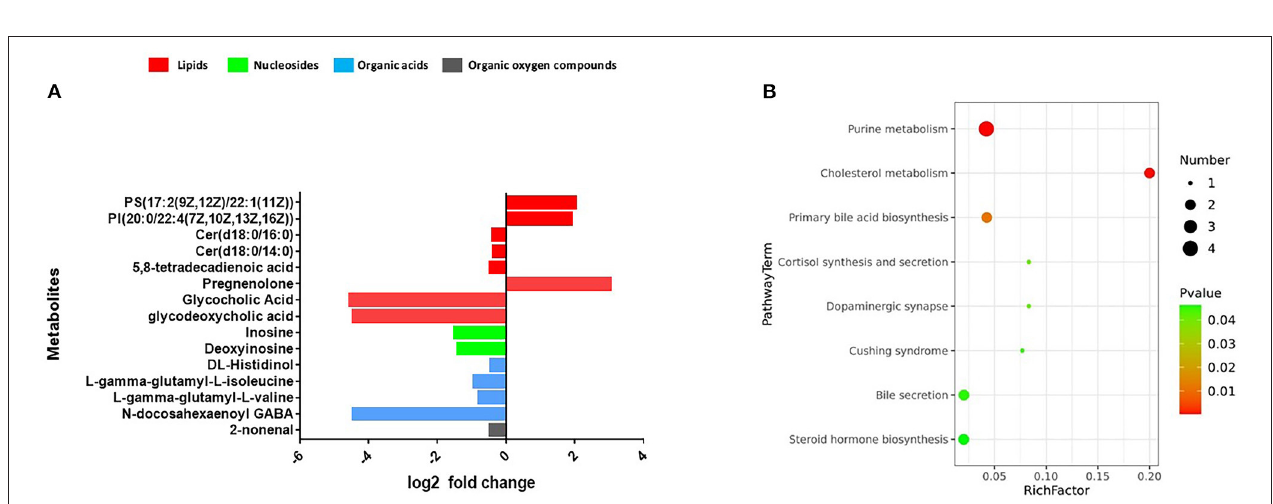
FIGURE 6 | (A) Fecal metabolomics changed after the intervention. (B) The significantly perturbed pathways by the intervention.